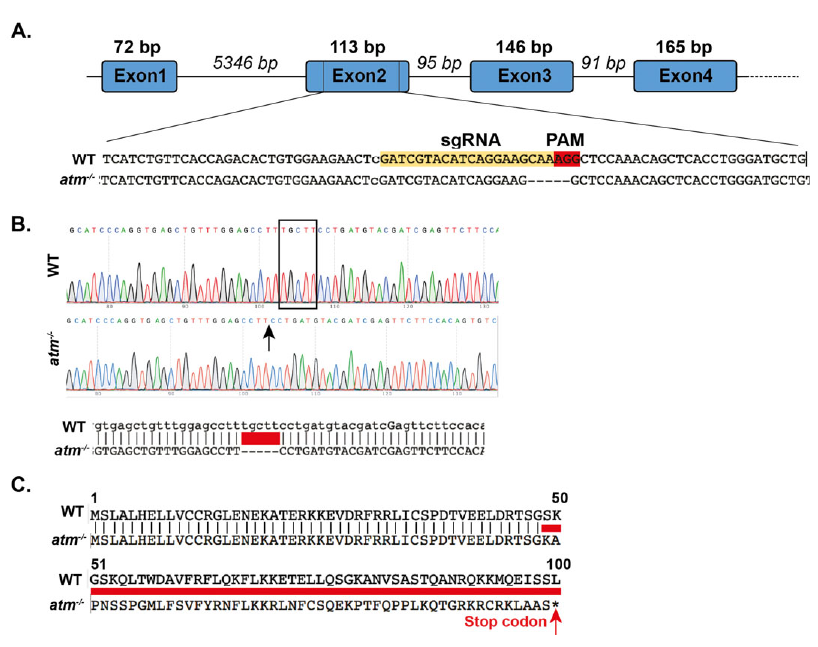
Figure 2. atm − / − mutant zebrafish generated by CRISPR-Cas9. ( A ) Schematic representation of the atm gene from exon 1 to exon 4. Wild type and atm − / − genomic sequences and predicted amino acid sequence of atm mutant alleles are shown. The sgRNA used to generate the mutant is shown in yellow, and the PAM sequence is in red. ( B ) Sanger sequencing and alignment of cDNA obtained from 2–5 dpf WT and atm − / − mutants confirms the 5 bp deletion at the mRNA level. In red the deleted sequence. ( C ) Alignment between the predicted amino acid sequence of WT and atm mutant alleles. The amino acids predicted to be generated by atm − / − mutants are indicated by the red line.